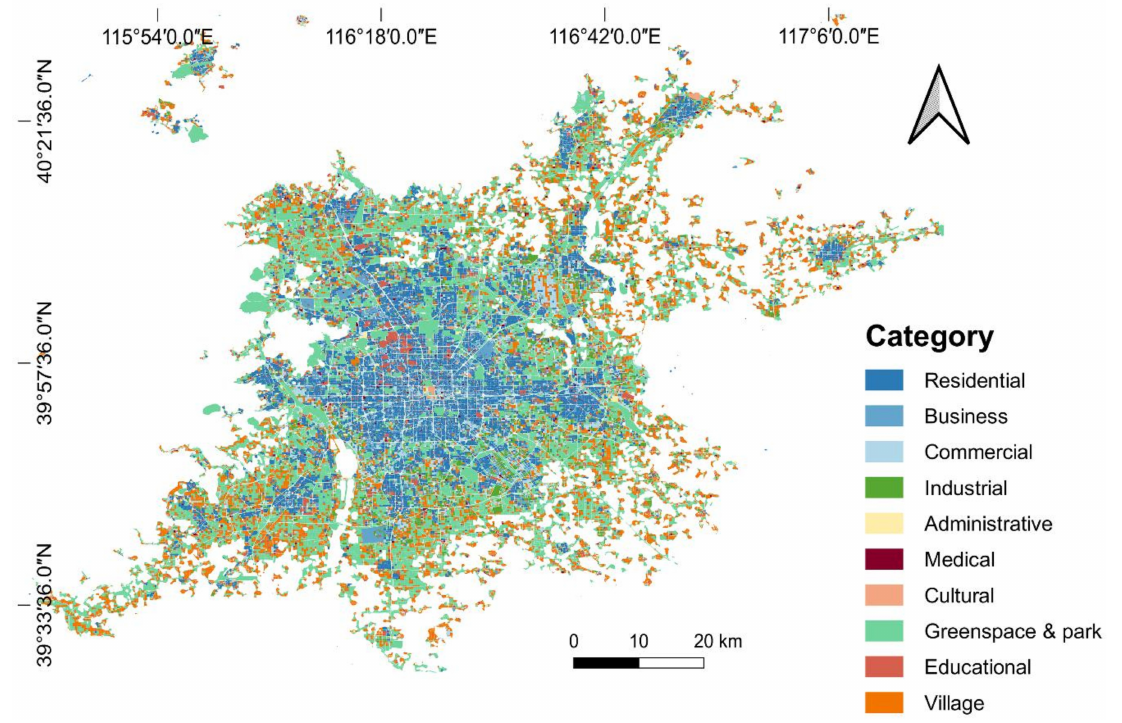
Figure 9. Map of EULUC-AOI (OSM+300 m grid) in Beijing, 2019.